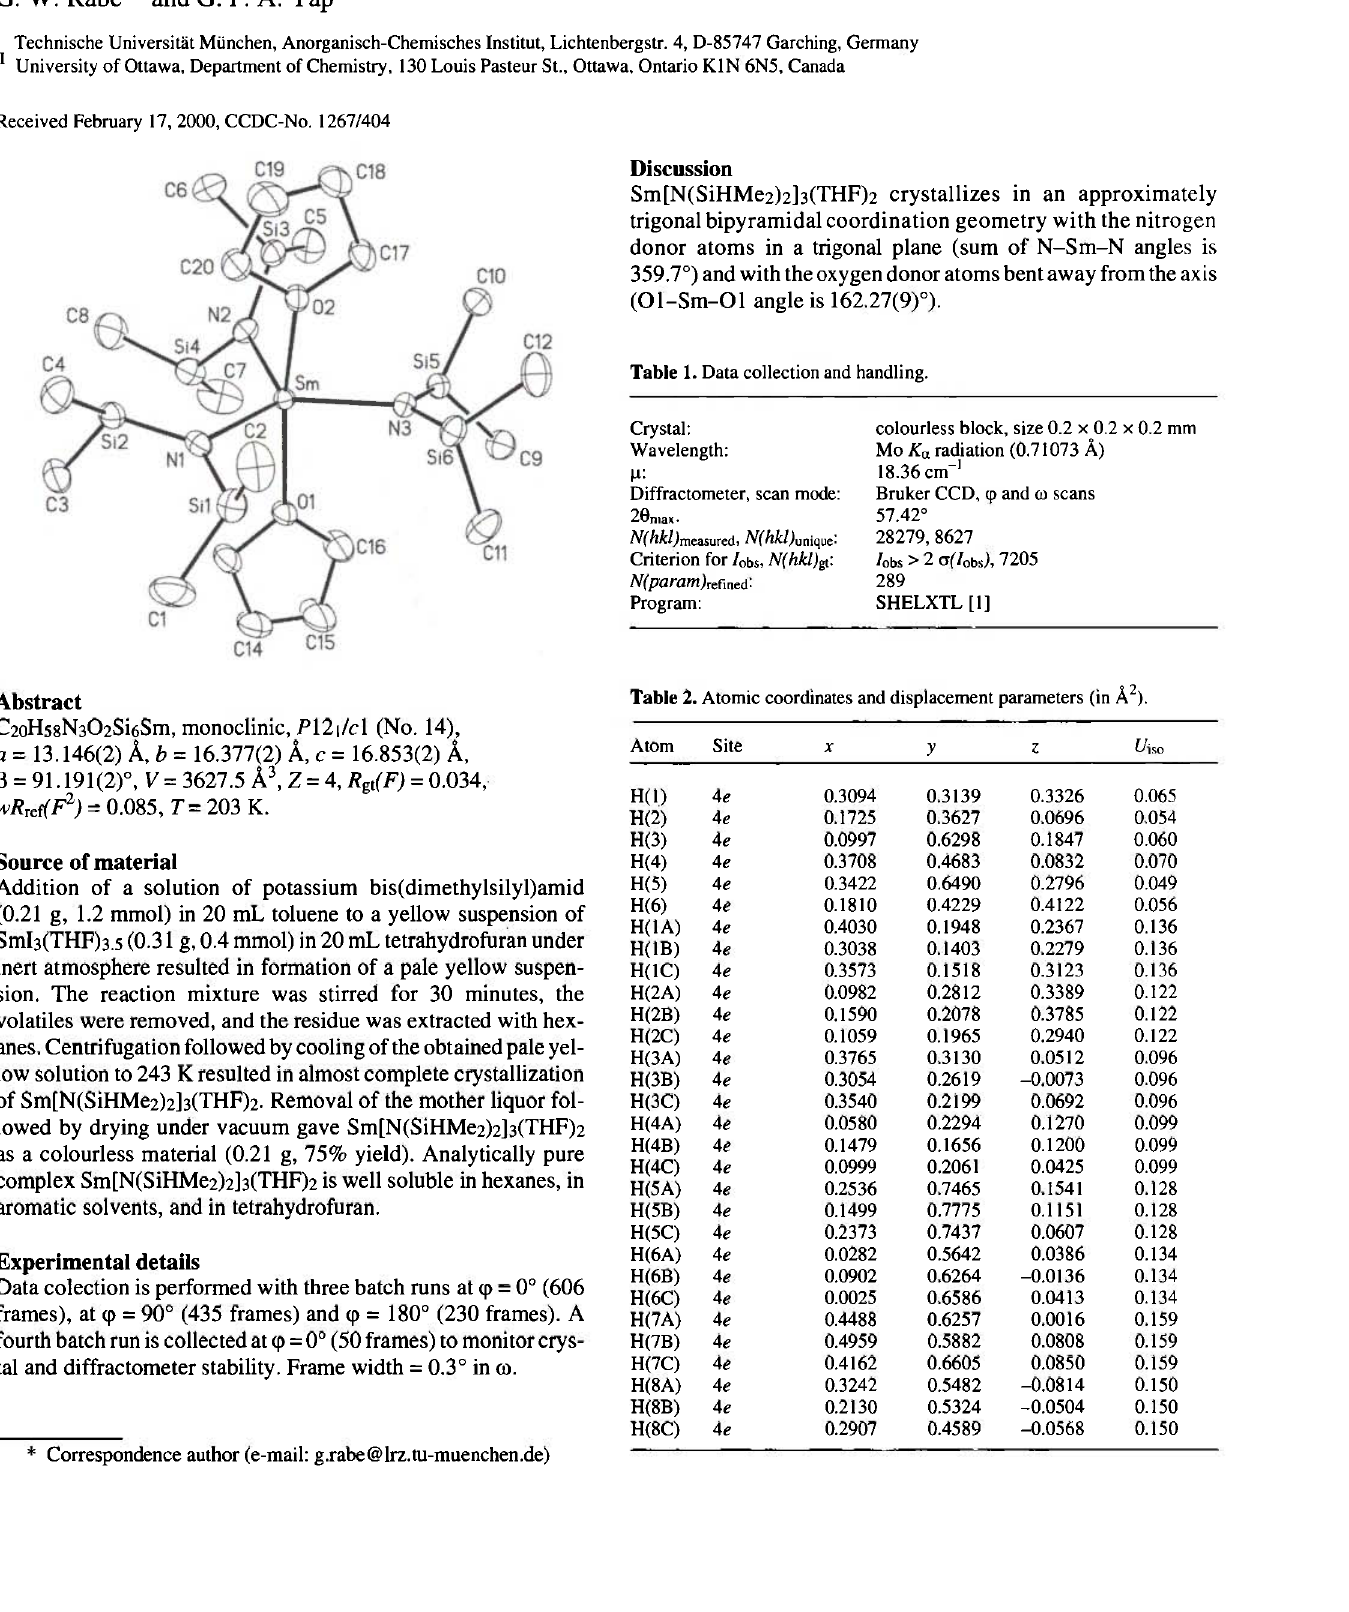
Table 1. Data collection and handling.